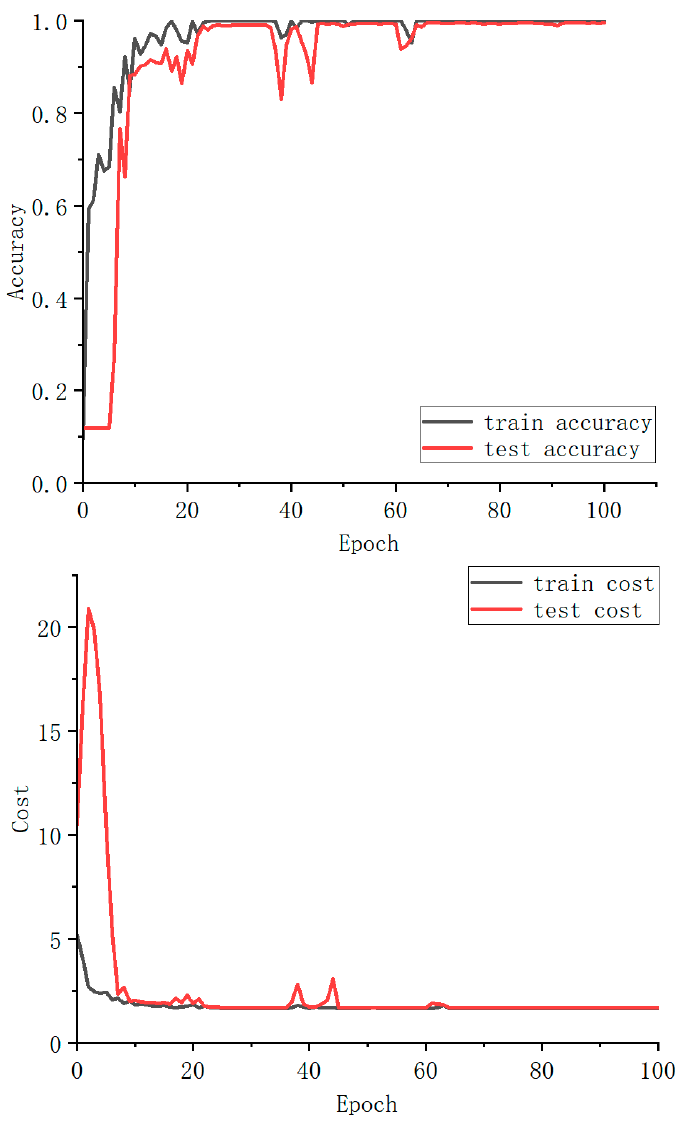
Figure 12. Training process loss and accuracy variation.